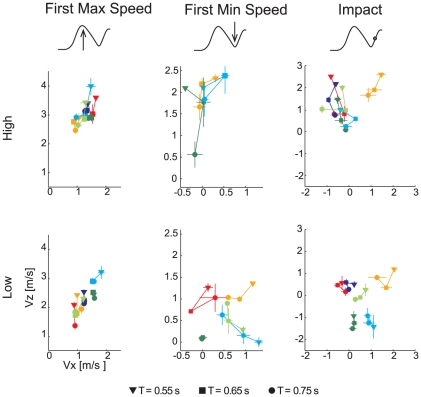
Inter-individual differences in wrist velocity at maximum speed, minimum speed, and impact.Wrist velocity components (mean ± SE; SE are reported only when number of trials per block was larger than 2) in the sagittal plane (x, anterior-posterior axis; z vertical axis) for each one of the three flight time conditions (T, indicated by different marker shapes) are illustrated separately for the two different arrival heights (first row: high, second row: low). Subject color coding is the same as in Figure 2.